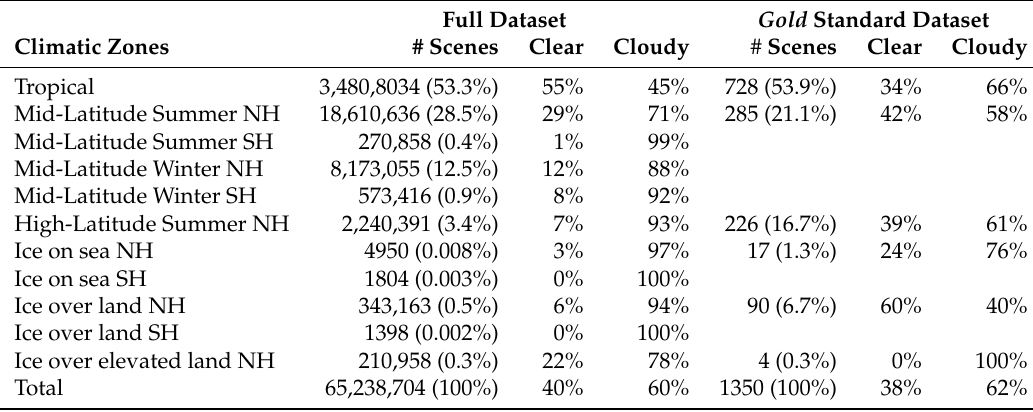
Table 4. Climatic zones considered in the paper and their numerosity in both the joint MODIS and SEVIRI dataset and the gold standard